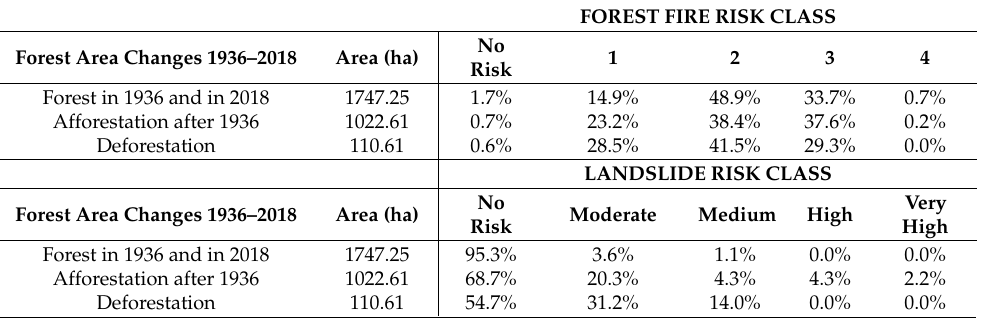
Table 5. Forest area changes in the period 1936–2018 in relation to fire and landslide